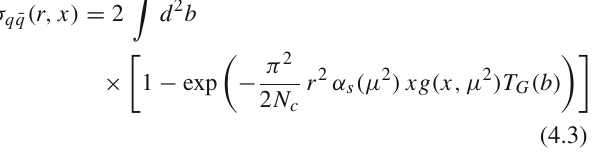
parametrisations accounting for the saturation phenomenon and the QCD-inspired Bjorken x - and hard-scale evolution the fits to the HERA DIS